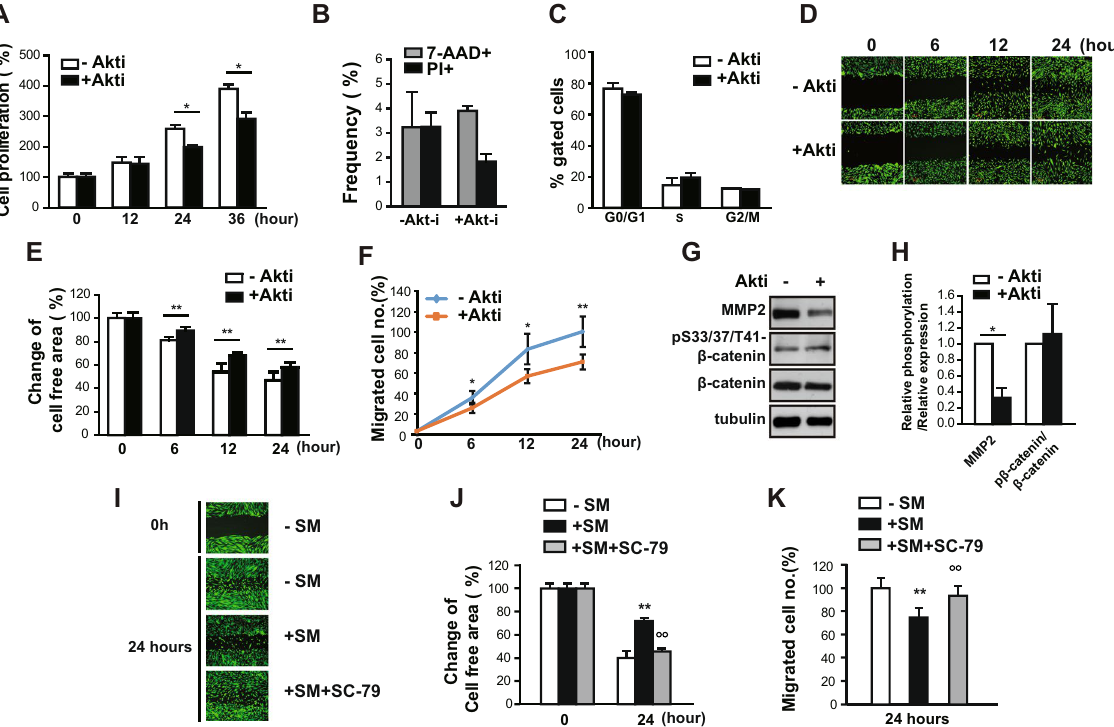
Figure 4. Akt decreased cell growth and migration in human eSCs. ( A ) Human eSCs were incubated with or without 1 μ M Akti for the indicated times. The cells were counted using a cell counter. ( B ) The cells were treated as in ( A ), stained with either 7-AAD or PI, and analyzed by flow cytometry. ( C ) The cells were treated as in ( A ), stained with PI, and analyzed by flow cytometry. ( D – F ) The cells were scratched with a T200 tip and then incubated with or without 1 μ M Akti for the indicated times. ( D ) The cells were stained using the CytoPainter Cell Tracking Staining Kit and photographed. ( E ) The cell-free area was measured using ImageJ and change of cell-free area was calculated. ( F ) The number of migrated cells was counted using ImageJ. ( G,H ) The cells were treated as in ( A ), lysed, and subjected to western blotting. ( H ) Western blot images were analyzed using ImageJ to determine the phosphorylation of pS33/37/T41- β -catenin relative to β -catenin and the expression of MMP-2 relative to tubulin. ( I – K ) The cells were scratched with a T200 tip and incubated with or without 0.2 μ g/ml SC-79 under SM conditions for 24 h. ( I ) The cells were stained using the CytoPainter Cell Tracking Staining kit and photographed. ( J ) Cell-free areas were measured using ImageJ and the changes in the cell-free areas were calculated. ( K ) The number of migrated cells was counted using ImageJ. Abbreviations: simulated microgravity (SM); 7-aminoactinomycin D (7-AAD); propidium iodine (PI). Data are expressed as mean ± SD, with paired t -tests performed as indicated. * P < 0.05, ** P < 0.01 versus control at each indicated time; °° P < 0.01 versus SM exposed